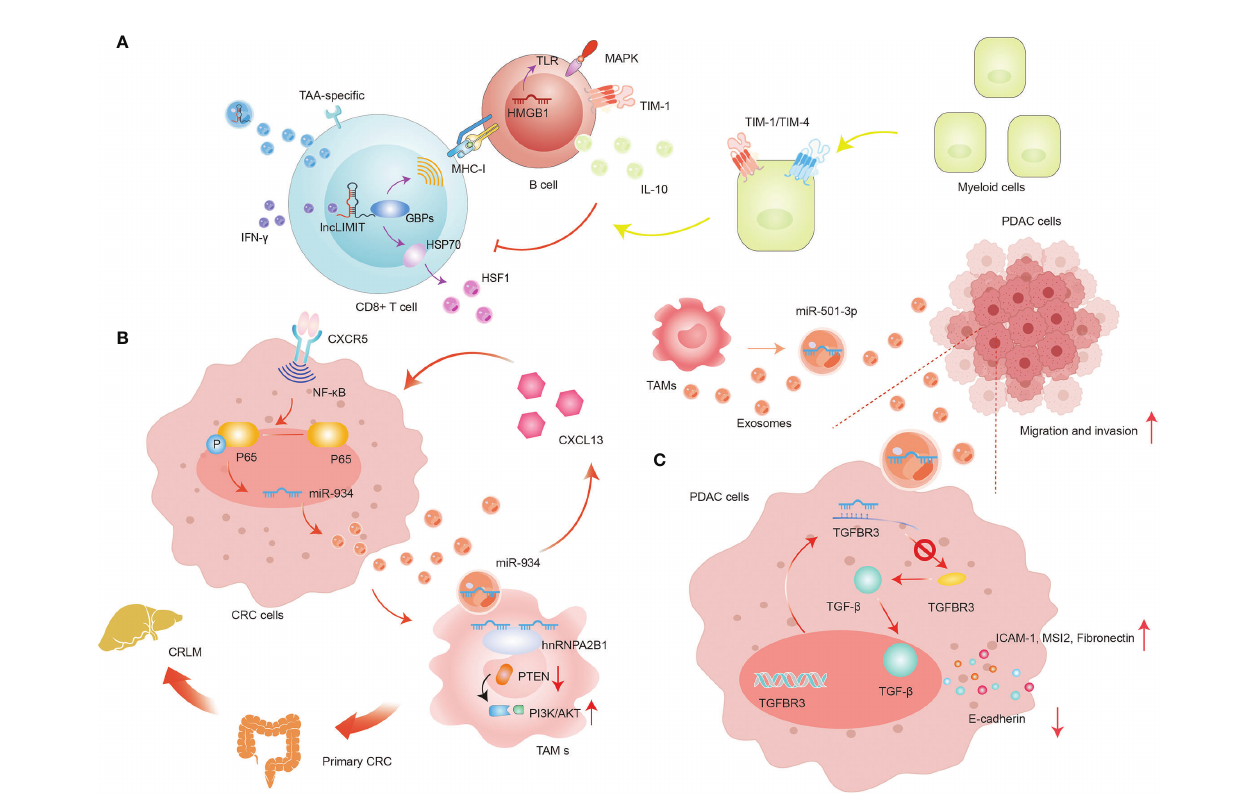
FIGURE 4 | The regulation of exosomal ncRNAs in immune cells. (A) The regulation of exosomal lncRNA LIMIT in T cells. (B) The positive-feedback loop of CXCL13/CXCR5/NF- k B/p65/miR-934 in CRC cells. (C) The role of exosomal miR-501-3p in PDAC